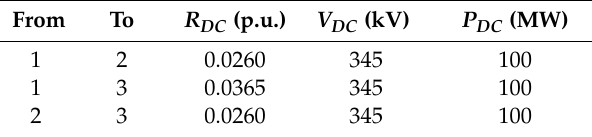
Table 5. Parameters of the DC